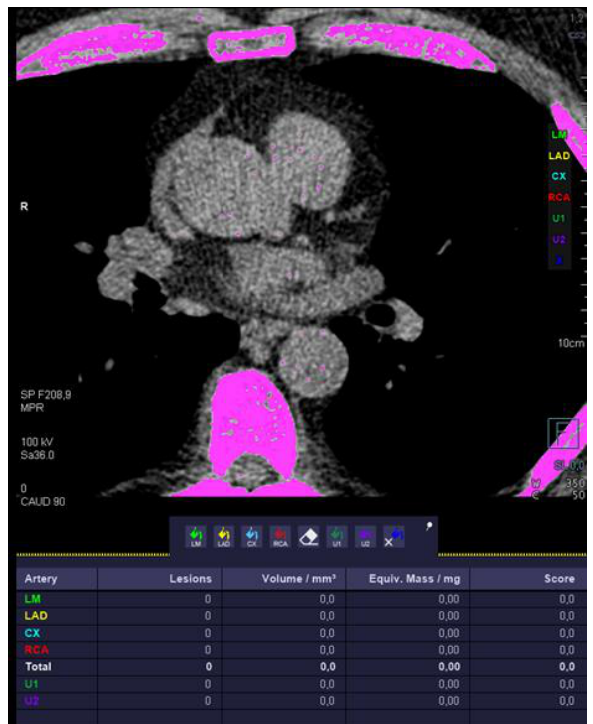
Figure 1. High-risk plaque (HRP) in a patient with CACS 0, a 70 years-old-male patient with ST- depression on ECG-treadmill stress test in V3-6. CT showed 37% diameters stenosis and a high-risk plaque (LAP 44 HU, positive remodeling) (white arrow) in the proximal left anterior descending artery (LAD), which were not detected by CACS ( b ). Diagnosis of non-obstructive CAD by CTA. Distal segment with deep myocardial bridging (MB), explaining stress test findings. ( a ) CTA (left: cMPR and right: 3-DVRT, spider view). LAD = left anterior descending. CX = circumflex artery.